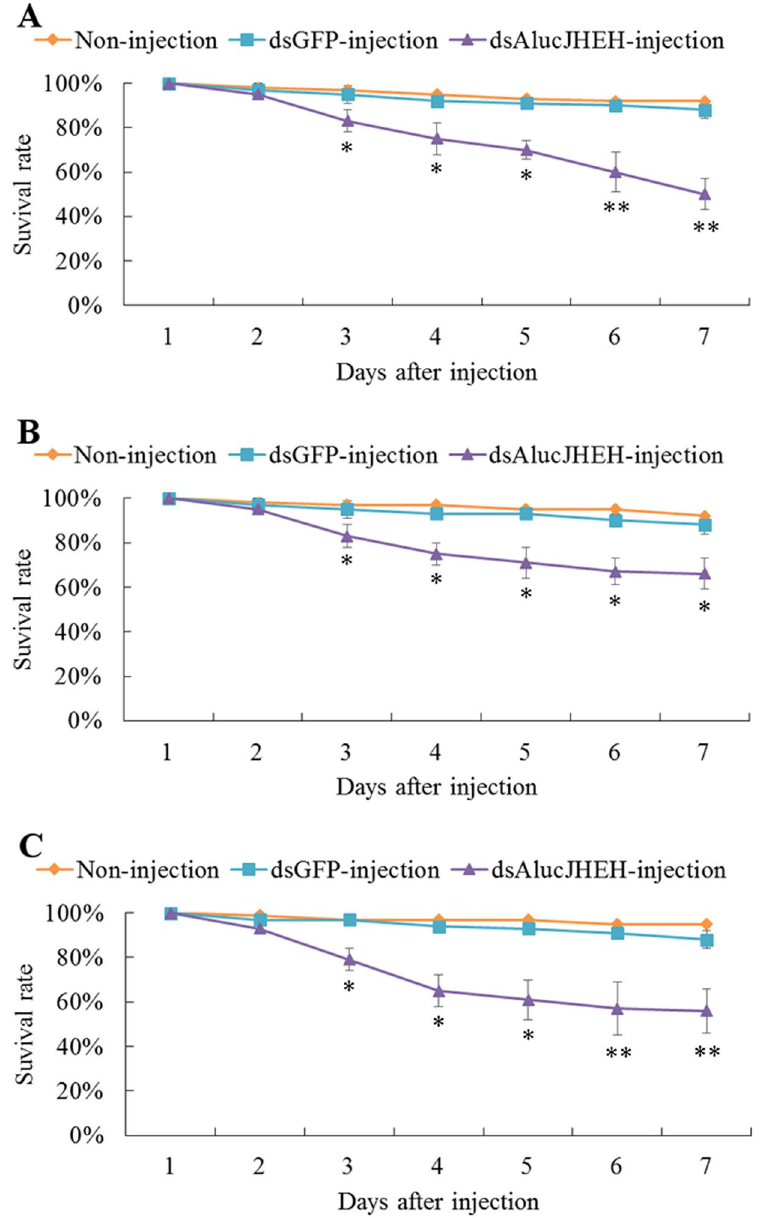
shown as the Mean ± S.E. * Indicates significant differences in the survival rate between the treated and control groups as determined by t -test ( P ≤ 0.05). ** Indicates differences at the p ≤ 0.01